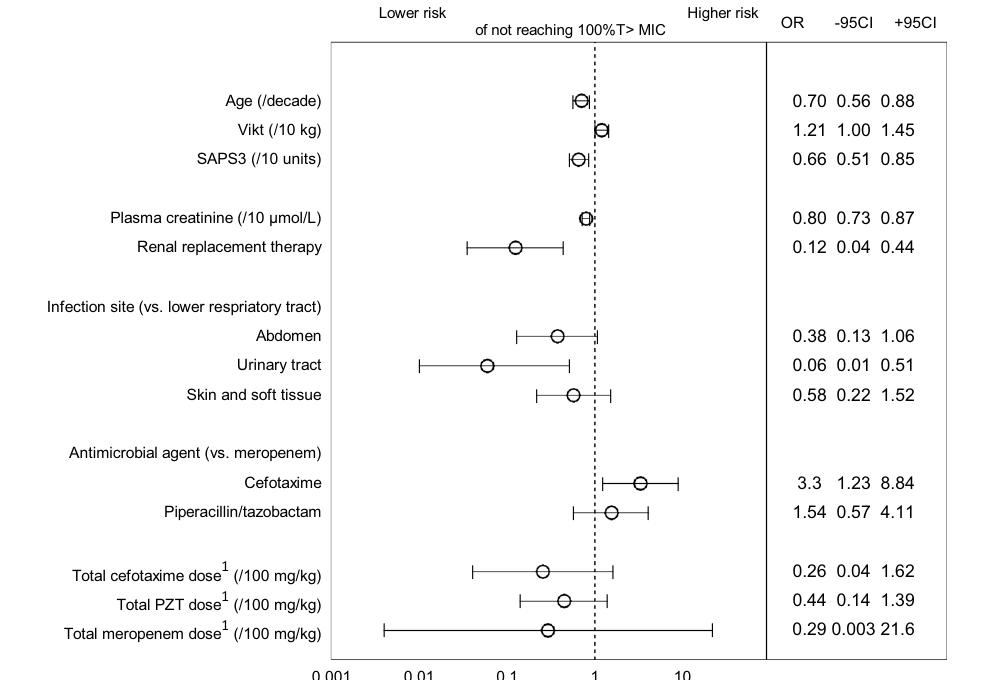
Figure 3. Forest plot illustrating predictive factors resulting in lower (to the left) or higher (to the right) risk for target failure of not reaching 100% T > MIC including odds ratios (OR) with 95% confidence intervals from univariate logistic regression. 1 Daily doses of antibiotics per body